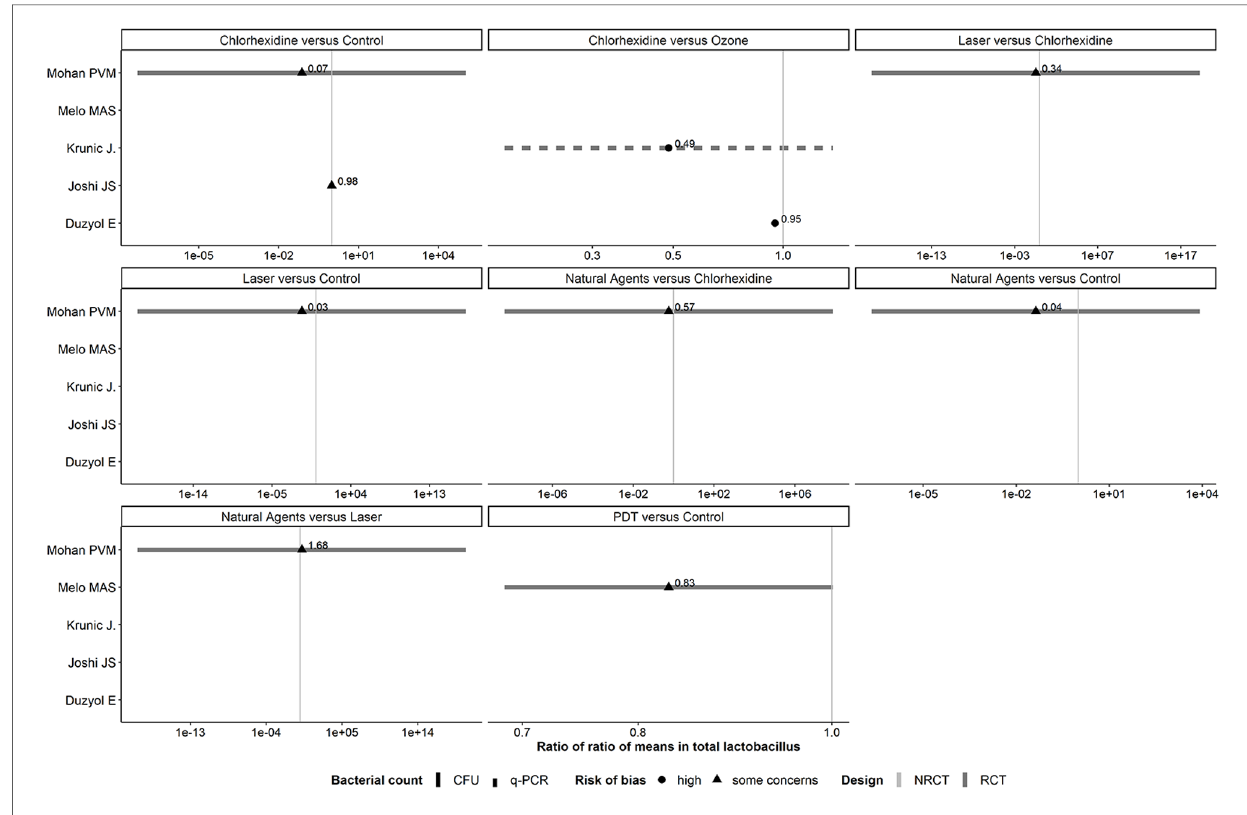
FIGURE 5 Forest plots showing roRoMs for Lactobacillus across the antiseptics